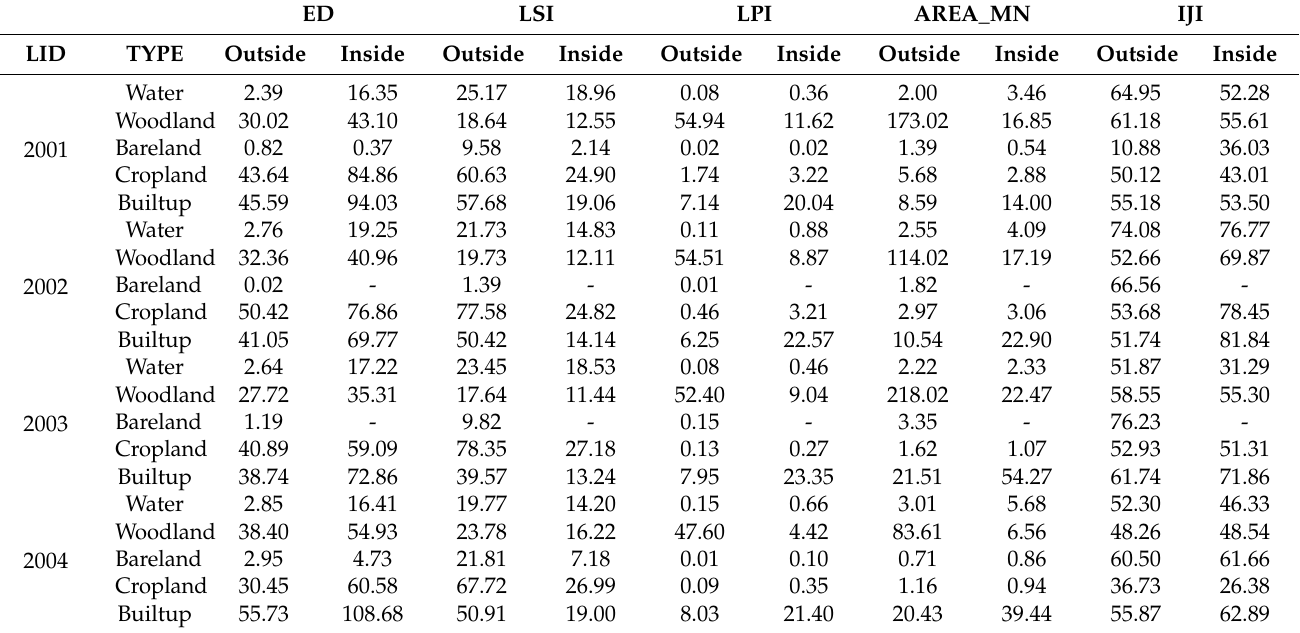
Table 3. Landscape pattern changes of various land use types in the L–S Creek